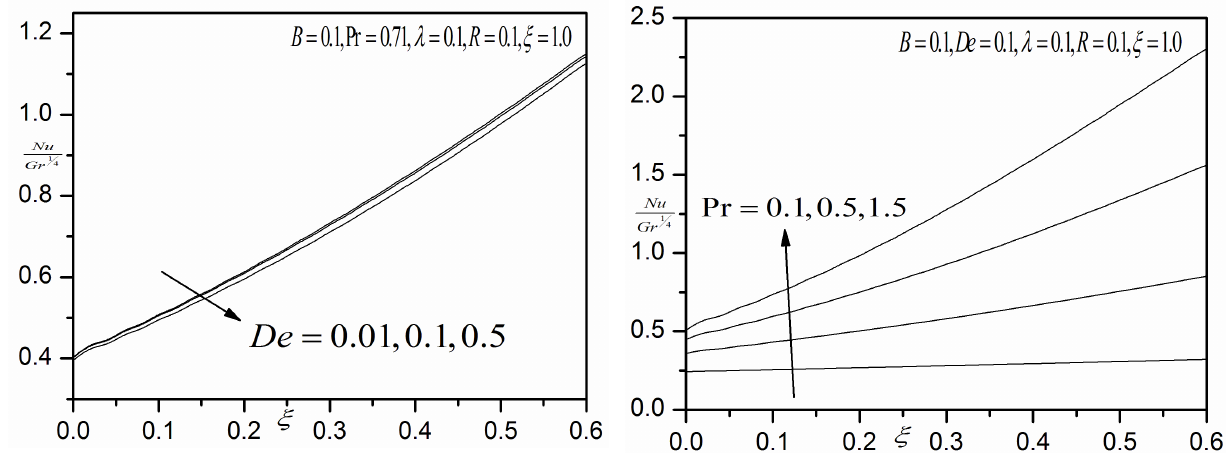
Fig. 17: Influence of De on Nusselt number.